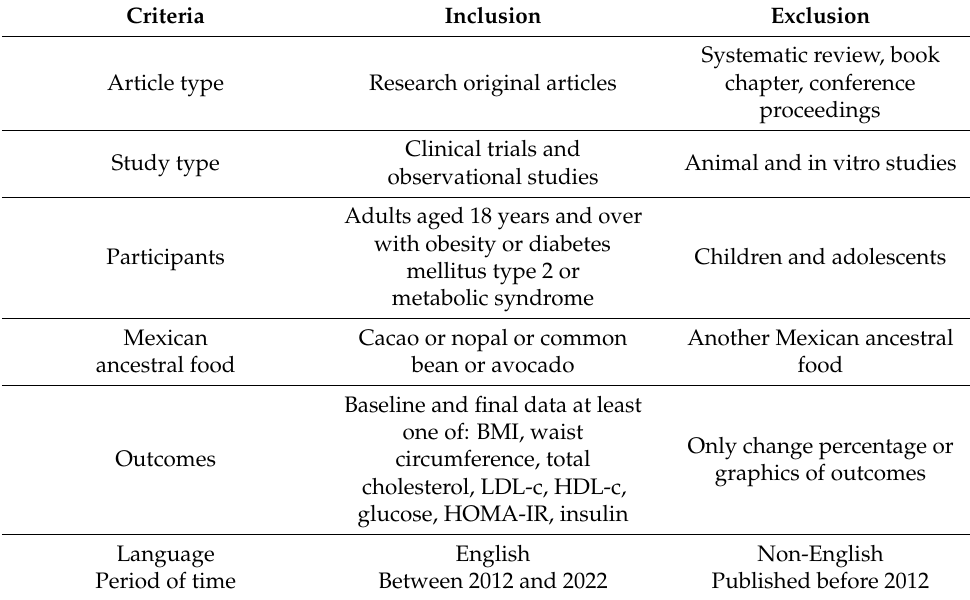
Table 1. Inclusion and exclusion criteria of selected